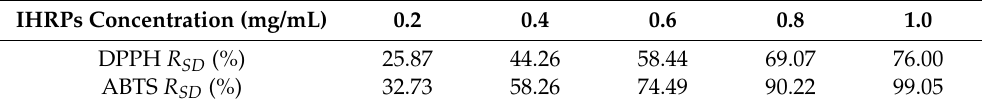
Figure 4. Ion-chromatographic spectra of monosaccharide composition of IHRPs: ( A ) standard Figure 4. Ion ‐ chromatographic spectra of monosaccharide composition of IHRPs: ( A ) standard mon ‐ monosaccharide and ( B ) IHRPs sample. osaccharide and ( B ) IHRPs sample. Table 5. Antioxidant activity of